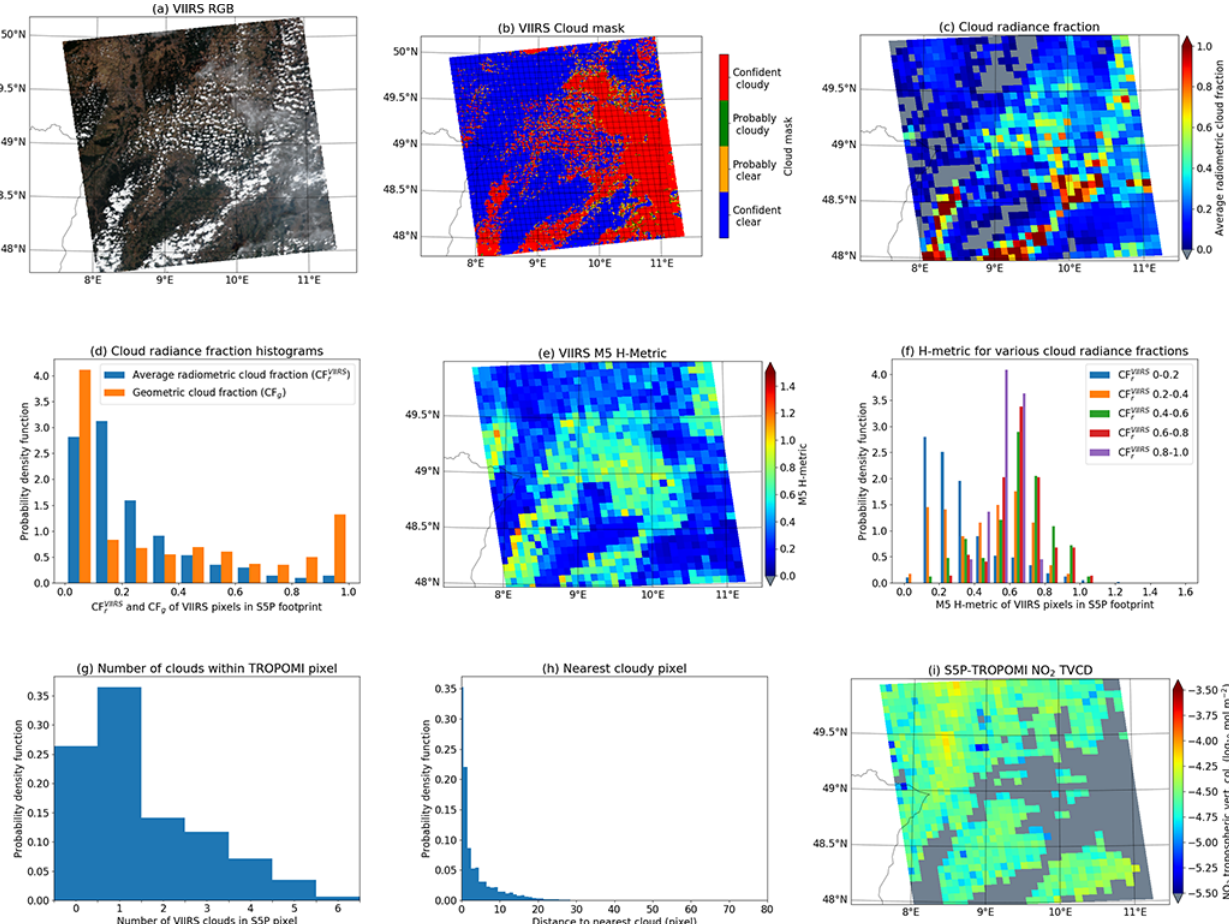
Figure A2. Examples of VIIRS data and cloud metrics for TROPOMI pixels for sub-region 02_01 and 2018/8/5. (a) VIIRS RGB. (b) VIIRS cloud mask with TROPOMI grid overlaid. (c) Cloud fraction for TROPOMI pixels. (d) Distribution of cloud fraction. (e) H metric for TROPOMI pixels. (f) Distribution of H metric for various cloud fractions. (g) Distribution of number of clouds within TROPOMI pixels. (h) Distribution of distance to nearest cloudy pixel. (i) NO 2 column as retrieved from TROPOMI data. Grey pixels indicate data with low quality flag.